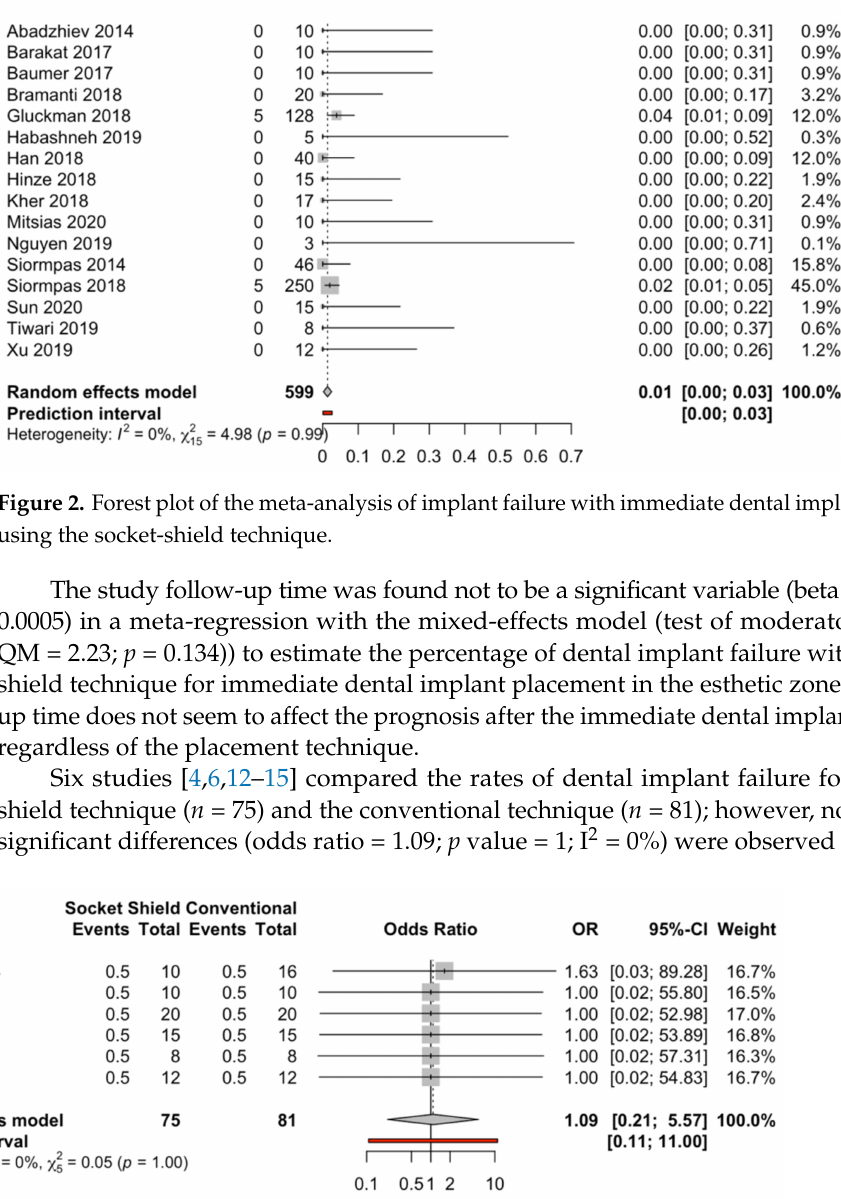
Figure 3. Forest plot of the rates of dental implant failure (odds ratio) for immediate dental implant placement using the socket-shield technique in the esthetic zone and conventional immediate dental implant